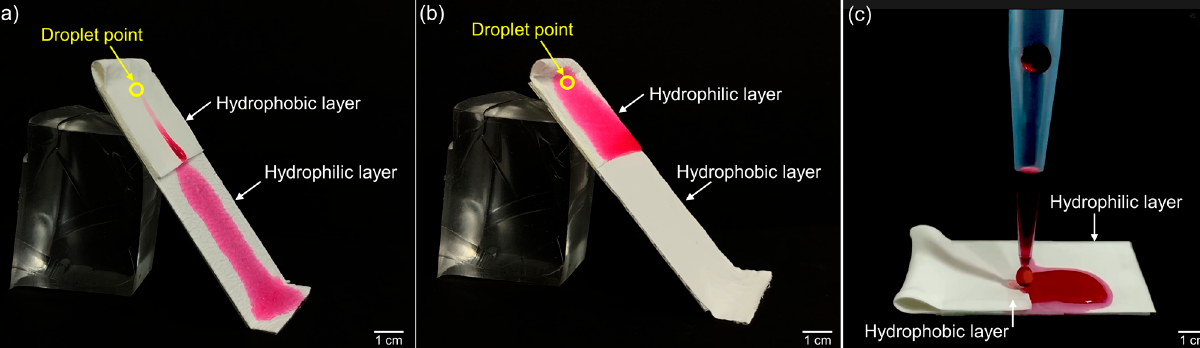
Figure 2. Results of wettability test on the tilted bilayer membrane. ( a ) The absorbed watercolor ink (red) on hydrophilic surface at lower area and ( b ) upper area, and ( c ) the aspects of repelling and attracting water on the bilayer membrane.